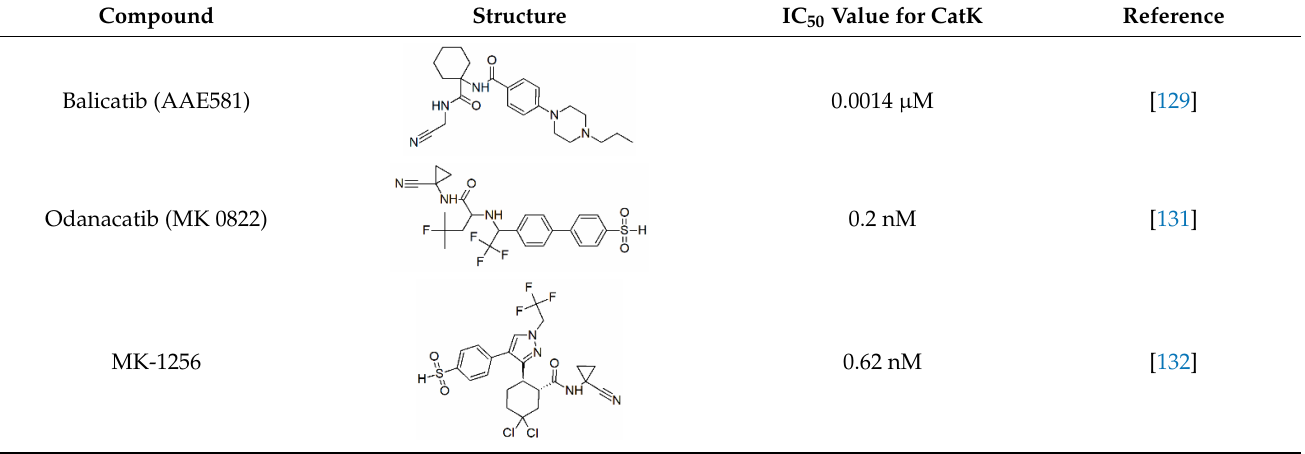
Table 5. Structures and IC 50 values obtained for peptidic nitriles, selective inhibitors of cathepsin K.